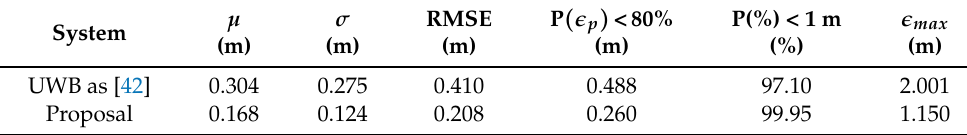
Table 9. Comparison of all